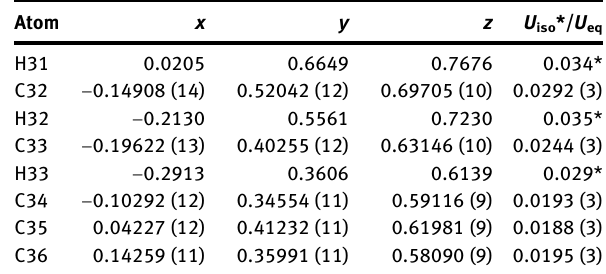
Table  : Fractional atomic coordinates and isotropic or equivalent isotropic displacement parameters (Å 